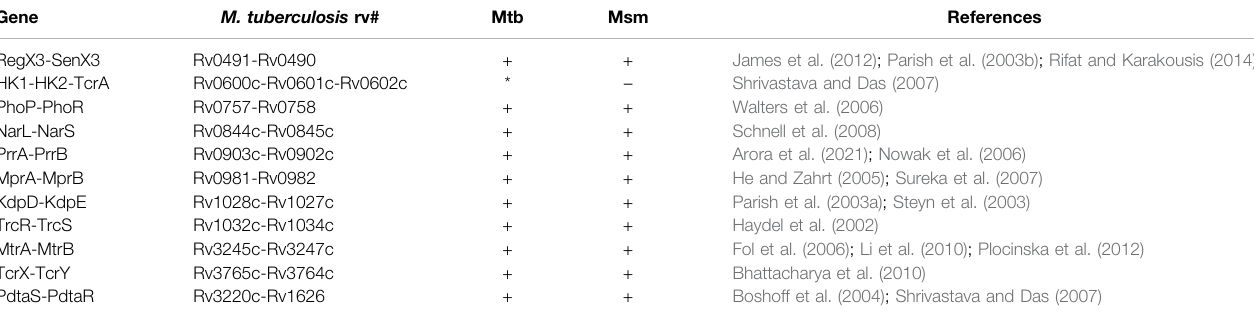
TABLE 2 | Conservation of M. tuberculosis H37Rv TCSS in M. smegmatis . Gene